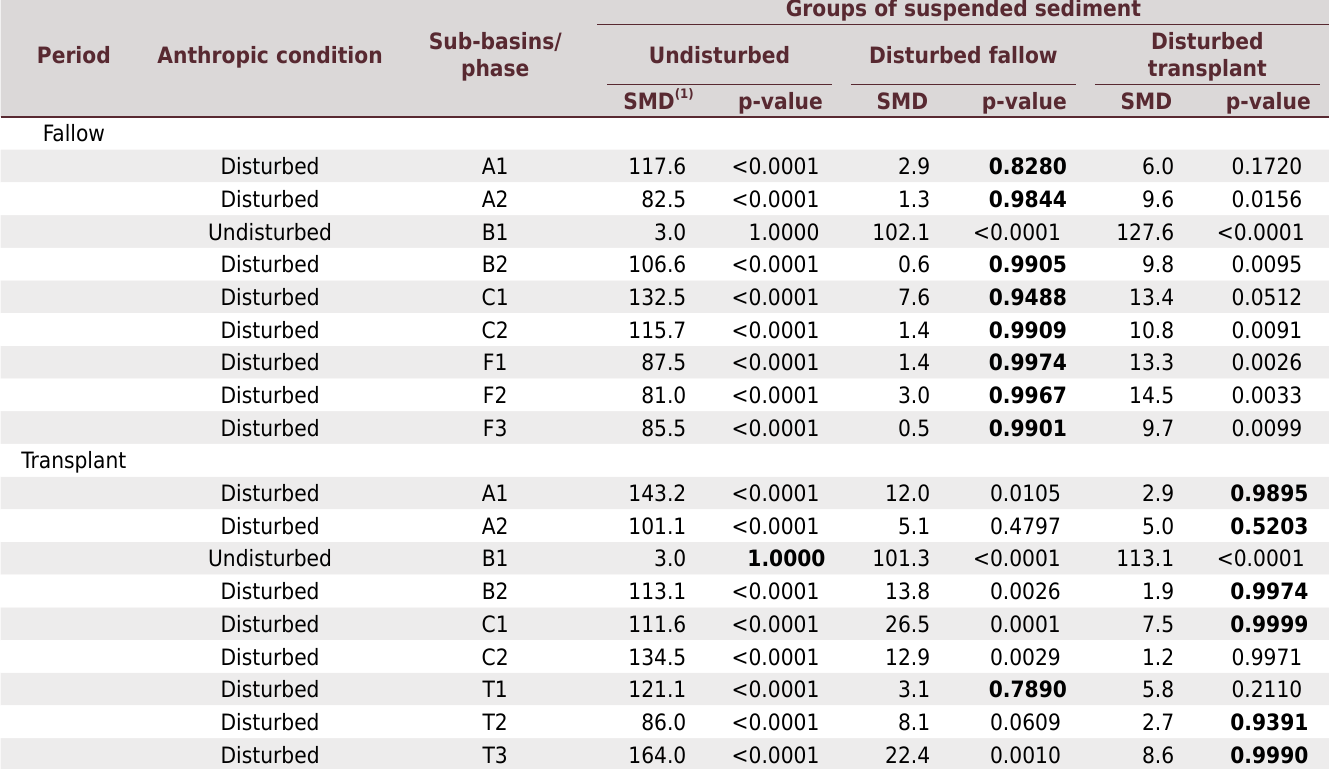
Table 6. Classification of sediment samples by discriminant analyses using the P forms of sediments eroded from the Agudo catchment, Rio Grande do Sul, Brazil